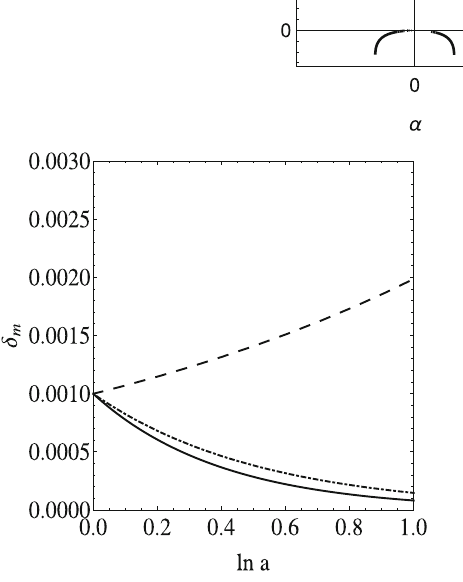
Fig. 9 The evolution of matter density perturbation for α = 0 (solid curve), α = 1 (dotted-dashed curve) and α = 3 (dashed